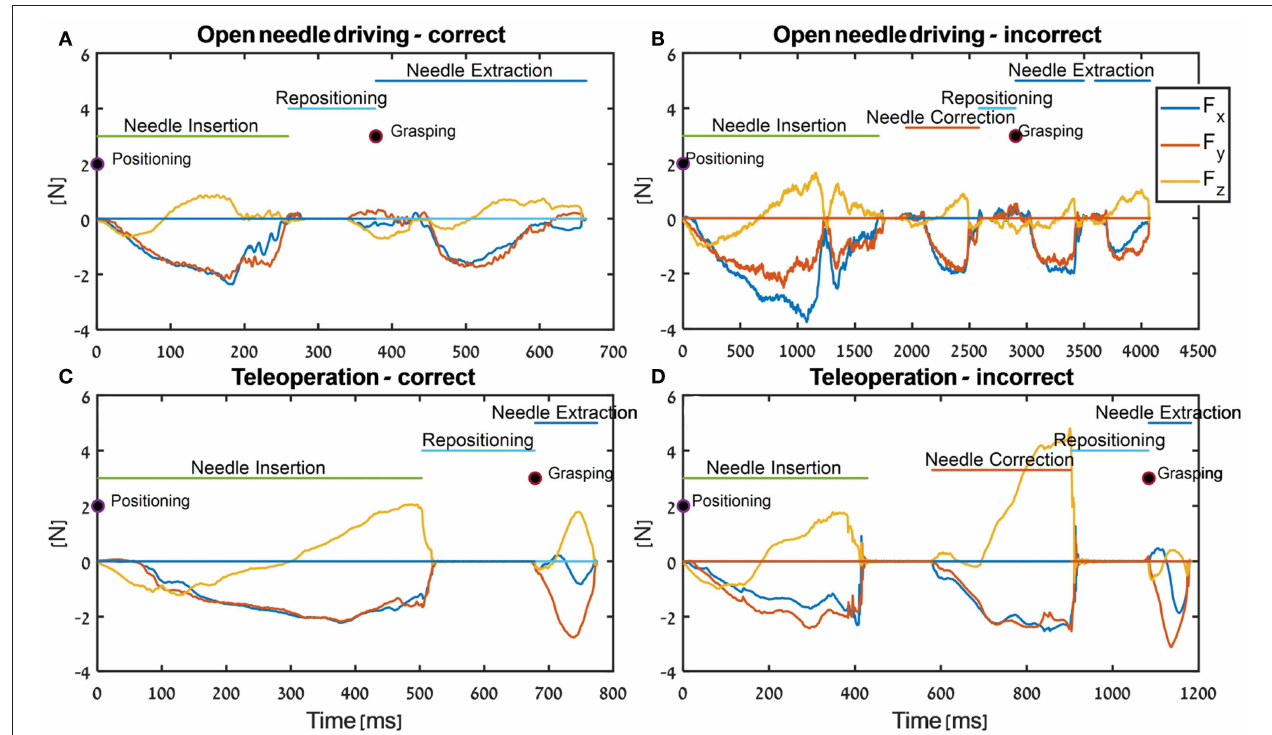
FIGURE 8 | Examples of force trajectories in each axis during needle-driving trials in open needle driving (A,B) and in teleoperation (C,D) . We present force trajectory for a trial that was preformed correctly (open needle driving - A , teleoperation - C ) and for a trial that was preformed incorrectly (open needle driving - B , teleoperation - D ). In addition, the segments that were identified by the automatic segmentation algorithm are